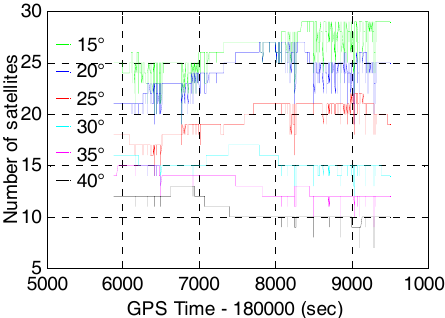
Figure 6. Number of Satellites of GPS/BDS/GLONASS (G+C+R) with cut-off elevation angle ranging between 15° and 40°.